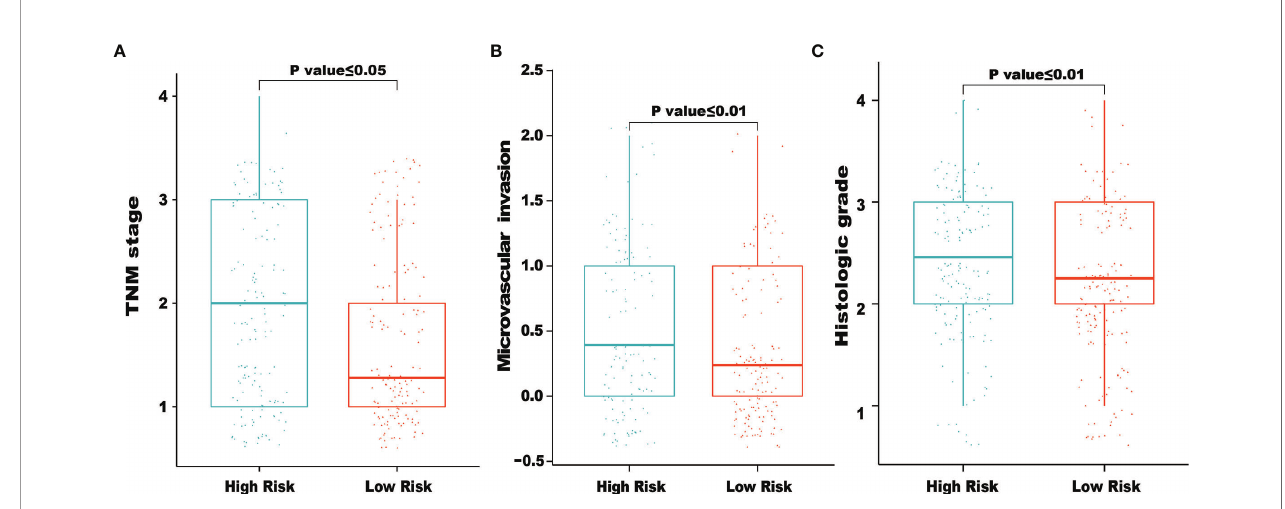
FIGURE 5 | Relationships between risk score and clinical characteristics. The fi gures demonstrated that higher of TNM stage (A) , microvascular invasion (B) and histologic grade (C) tended to correlated with higher risk